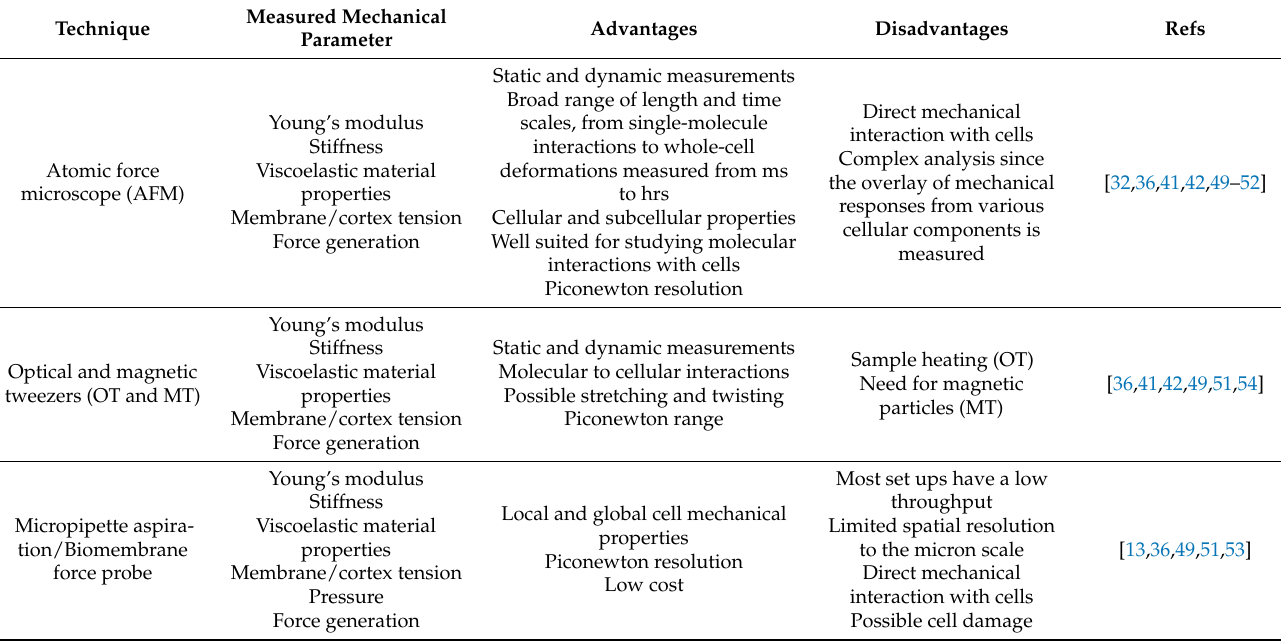
Table 1. Some of the most commonly used techniques to measure mechanical properties in biomechanics and mechanobiol- ogy that are based on a direct mechanical contact with the cells linked to the measured mechanical